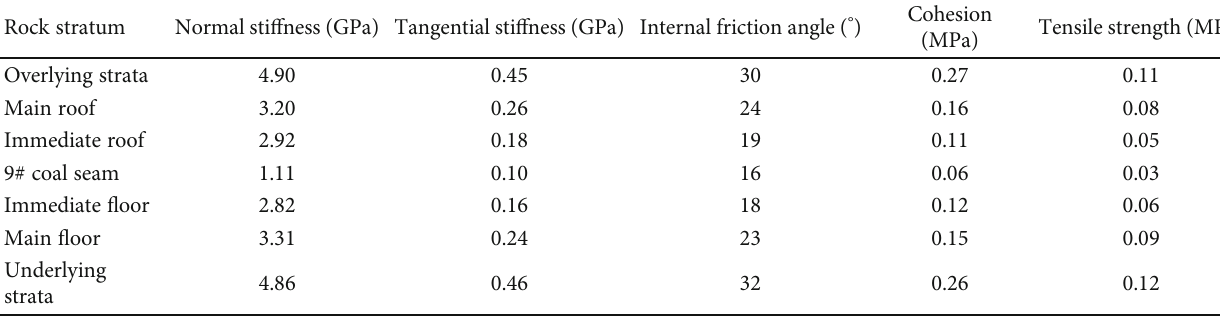
Table 8: Mechanical parameters of contact